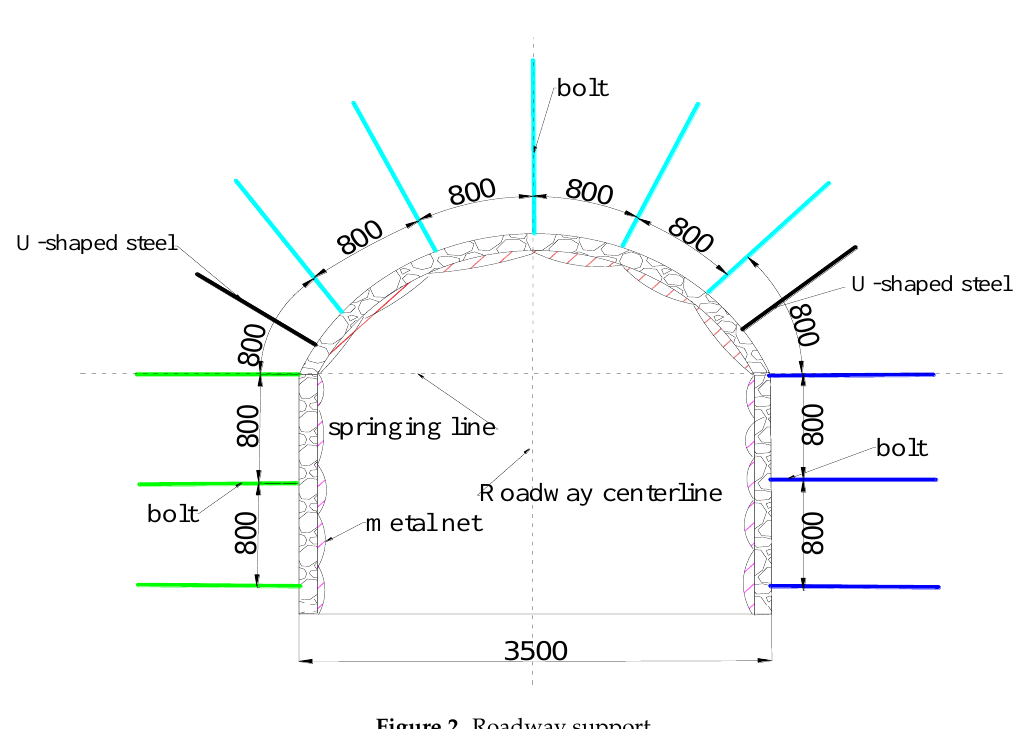
Figure 2. Roadway support.